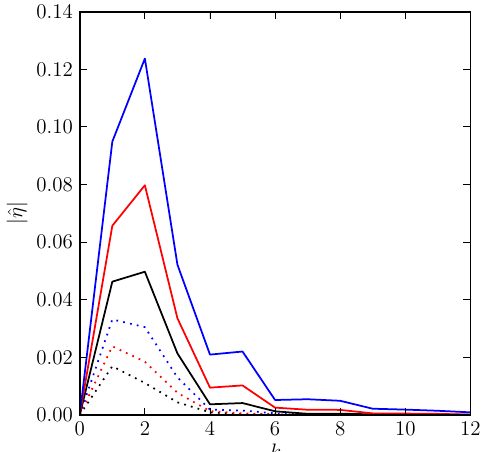
Figure 6. Case 1: magnitude of the Fourier modes of deformation of the buoyancy filament at t = 10 (dotted black), 12.5 (dotted red), 15 (dotted blue), 17.5 (solid black), 20 (solid red), 22.5 (solid blue). The modes ˆ η k are obtained by expressing the displacement of each buoyancy contour η from its initial position as a Fourier series in y . The magnitude all